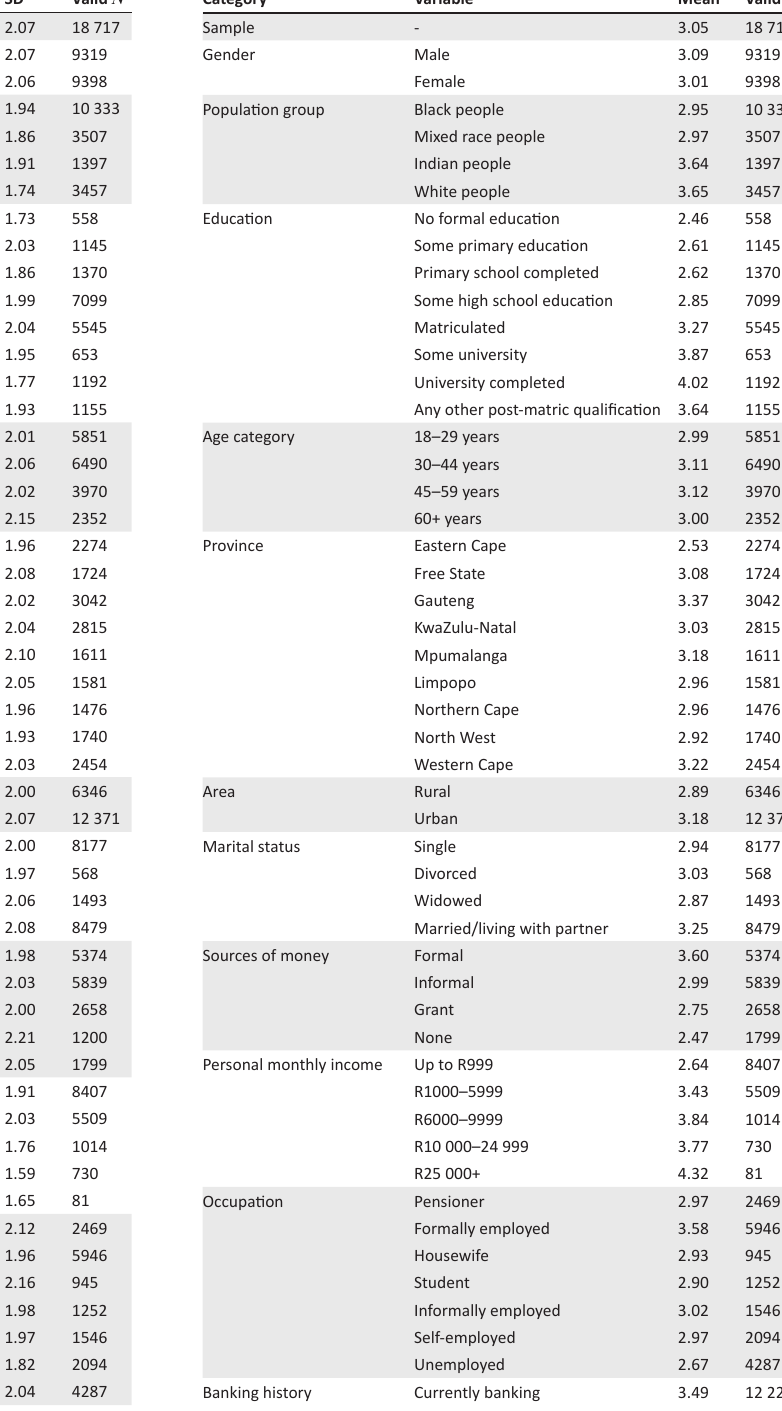
TABLE 1-A2: Average scores in the financial knowledge domain (pooled data). TABLE 1-A3: Average scores in the financial capability domain (pooled